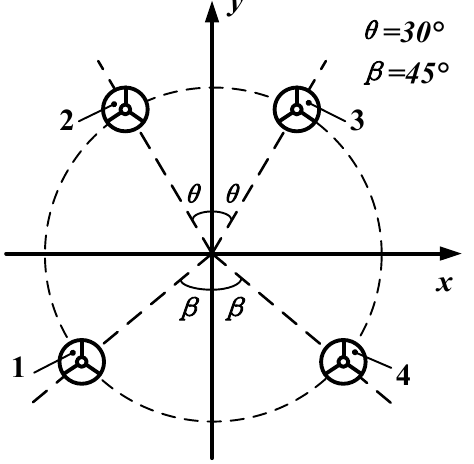
Figure 7. Thruster arrangement diagram.